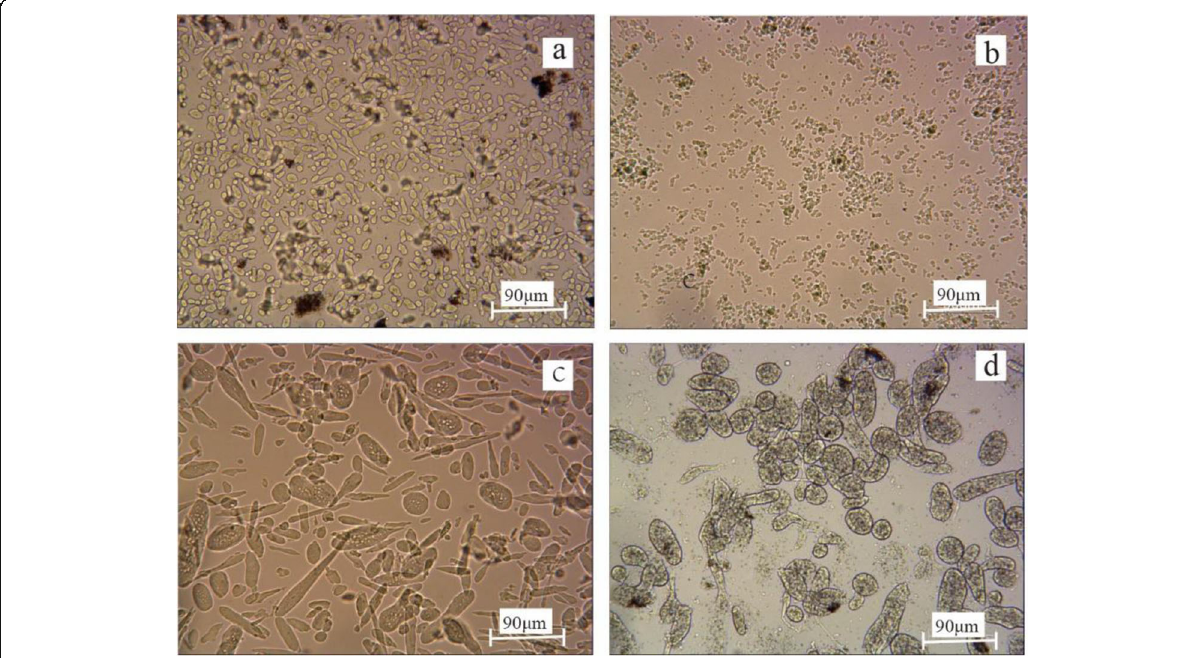
Fig. 6 The effect of wall material concentration on the morphology of composite condensate microcapsules. a Wall material concentration was 0.5%. b Wall material concentration was 1%. c Wall material concentration was 1.5%. d Wall material concentration was